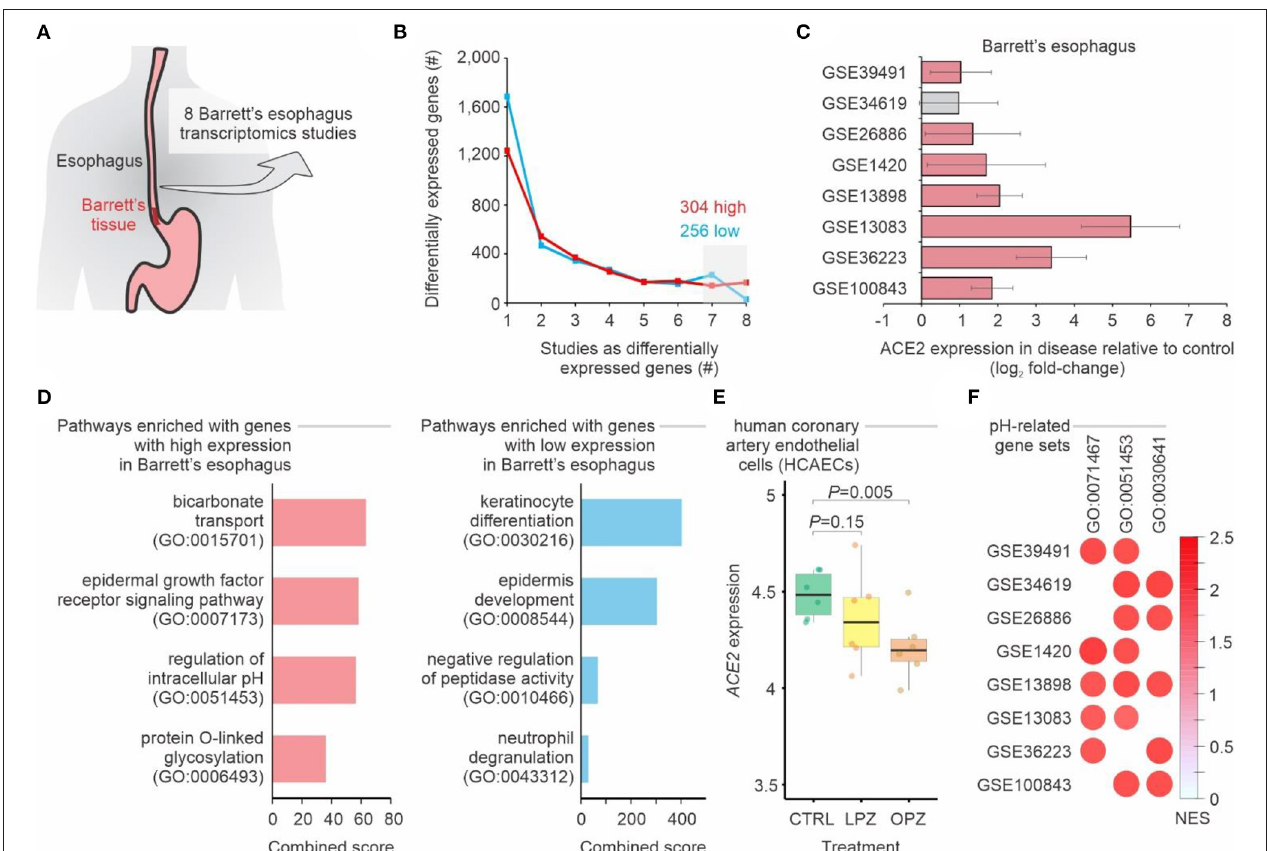
FIGURE 1 | Meta-analysis of gastroesophageal junction transcriptomes of patients with Barrett’s esophagus. (A) Meta-analysis of 8 studies of Barrett’s esophagus transcriptomes. (B) Number of differentially expressed genes in Barrett’s esophagus compared with non-Barrett’s esophagus. The lines show the number of genes (y-axis) considered up-regulated (red lines) or down-regulated (blue lines) in Barrett’s esophagus ( P -value < 0.05; log2 fold-change > 1; combined FDR < 0.01) in one or more datasets (x-axis). The numbers of up-regulated and down-regulated genes in at least seven studies are indicated. (C) ACE2 is upregulated in patients with Barrett’s esophagus. Each bar represents the log2 expression fold-change between patients and control individuals. The error bars indicate the 95% confidence interval. Bars in red represent a P -value < 0.05 and in gray a non-significant P -value. (D) Pathway enrichment analysis using the up-regulated and down-regulated genes in at least seven studies. The bars represent the combined score (x axis) calculated by Enrichr tool for selected Gene Ontology gene sets (y axis). (E) ACE2 expression in cells treated with proton pump inhibitors. Each boxplot represents the log2 expression of untreated (CTRL) cells and cells treated with either omeprazole (OPZ) or lansoprazole (LPZ). (F) Gene Set Enrichment Analysis (GSEA) of the 8 studies of Barrett’s esophagus transcriptomes using pH-related gene sets. The size and color of the circles are proportional to the normalized enrichment score (NES) of the gene sets (columns) on each study (rows). The Gene Ontology IDs are indicated at the